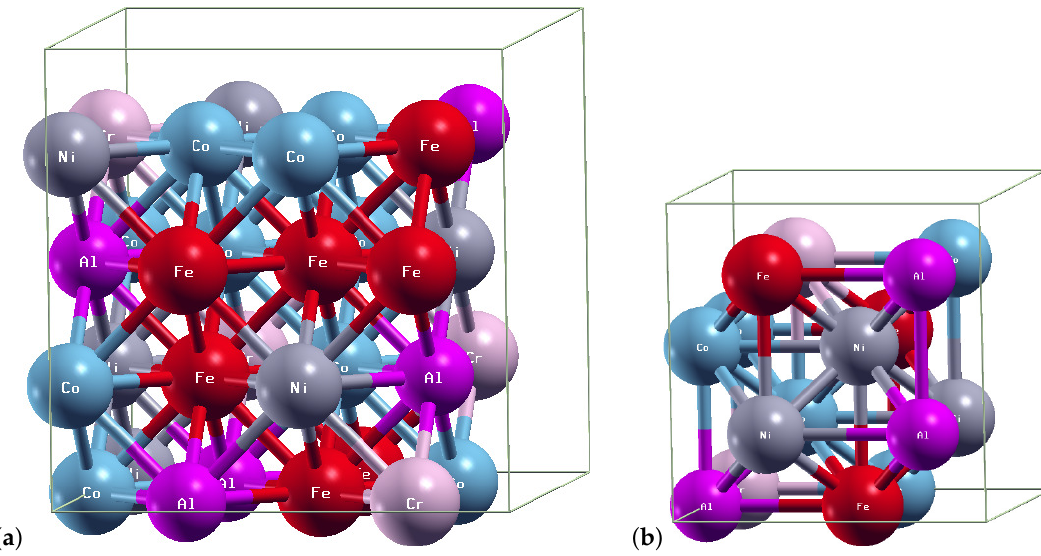
Figure 1. Typical 2 × 2 × 2 supercells of Co-Cr-Fe-Ni-Al HEAs: ( a ) FCC structure with 32 atoms and ( b ) BCC structure with 16 atoms. Only the atoms belonging to one supercell (FCC/BCC) are